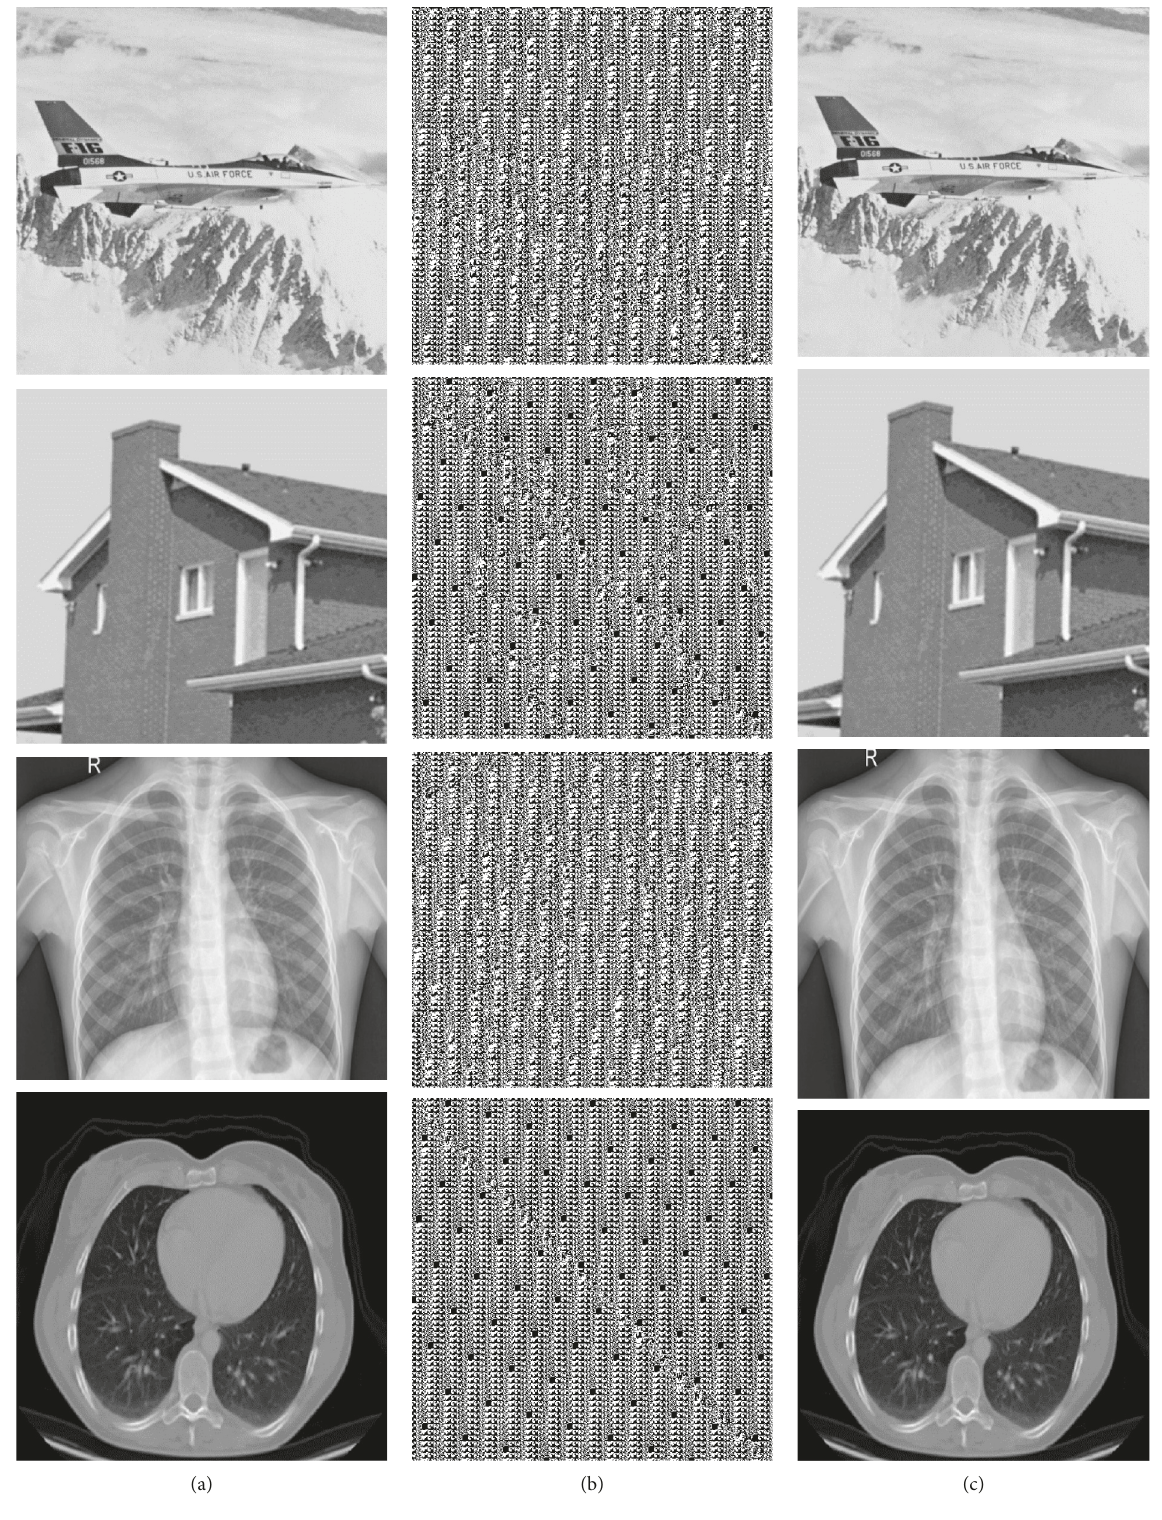
Figure 4: (a) Input sample images. (b) Encrypted images. (c) Decrypted